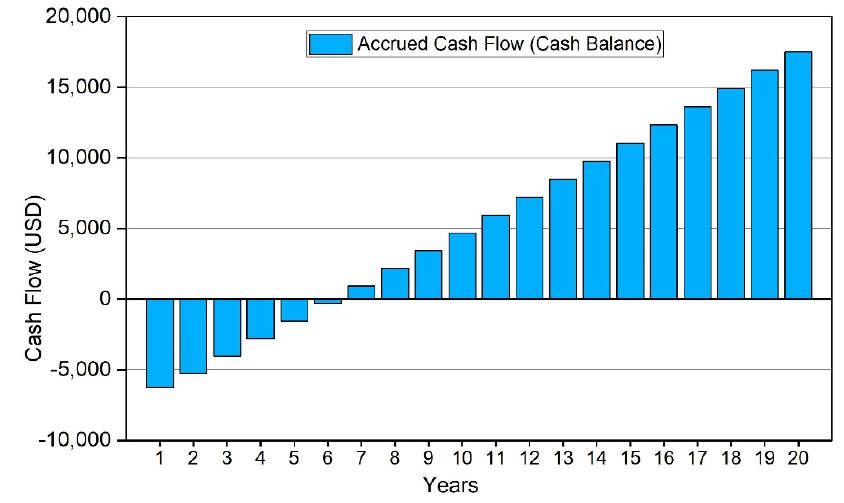
Figure 13. Cash balance comparison—year-wise comparison.